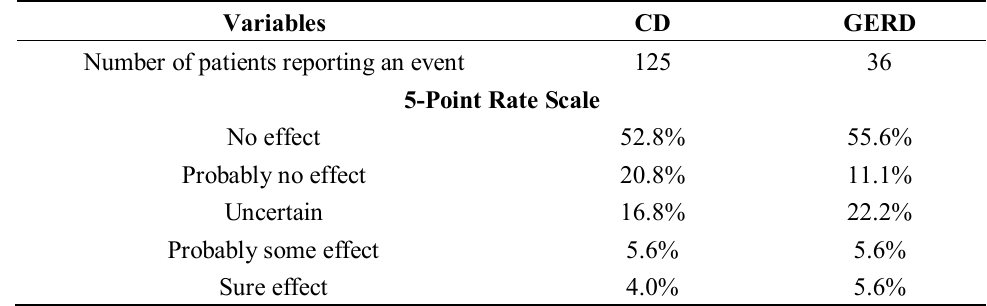
Table 3. Patients’ opinion about the effect of the reported event on the development of the disease Scale in CD and control (GERD) subjects according to the Paykel